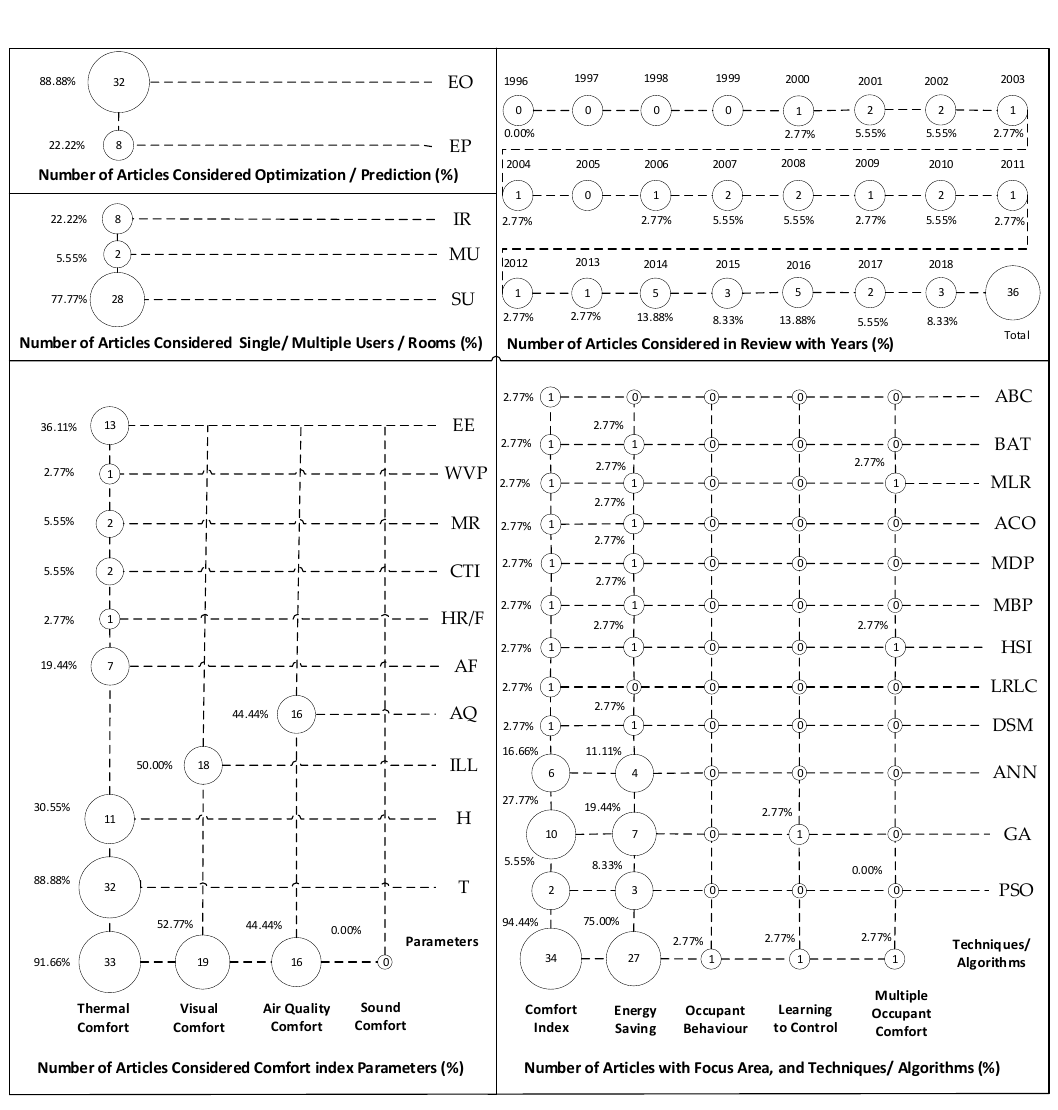
Figure 2. Visualization of a systematic map of optimization techniques.